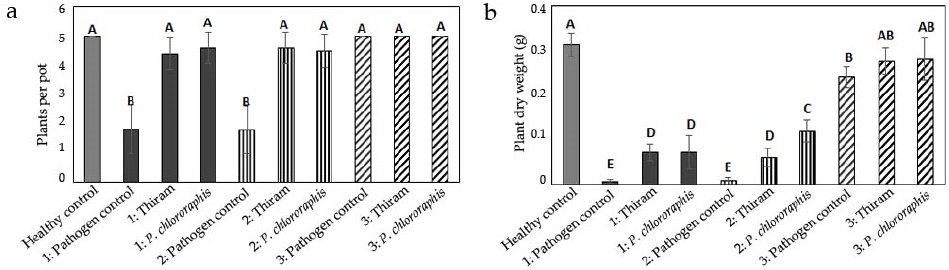
Figure 2. Effect of position of inoculum of Fusarium culmorum on ( a ) number and ( b ) biomass of maize seedlings and on efficacy of seed treatment with thiram or a suspension of Pseudomonas chlororaphis aurantiaca BI 7439. Variant 1: inoculum of F. culmorum mixed homogenously in the entire pot volume; variant 2: inoculum of F. culmorum present only in the upper half of pots; variant 3: inoculum of F. culmorum present only in the lower half of pots. Means and standard deviation of five pots per treatment with five maize seeds each. Different letters above bars indicate statistically significant differences between the treatments (GLMM; p < 0.05).